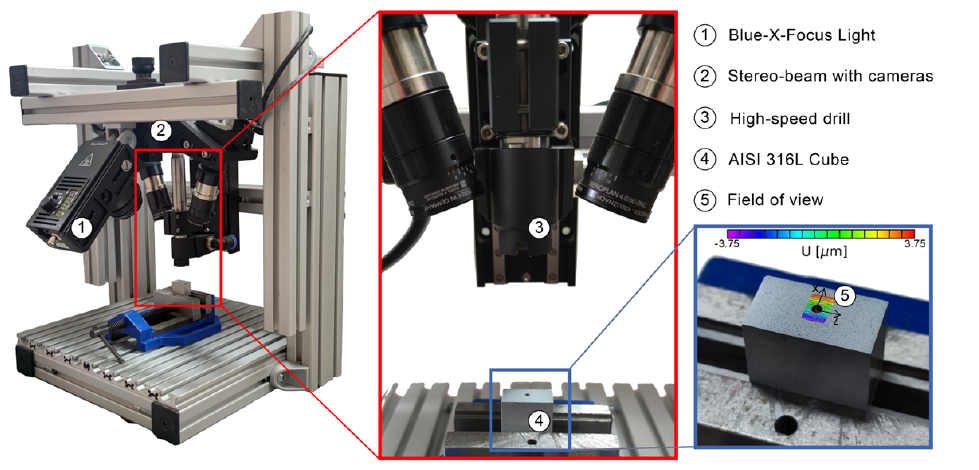
Figure 2. Residual strain analyzer (ReSA) experimental setup for IHD